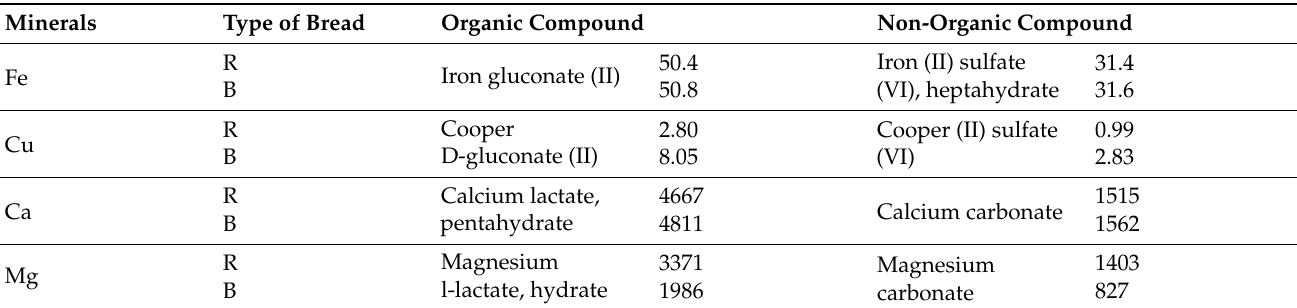
Table 4. The amounts of organic and non-organic compounds used as the source of selected minerals added to the breads (mg/100 g